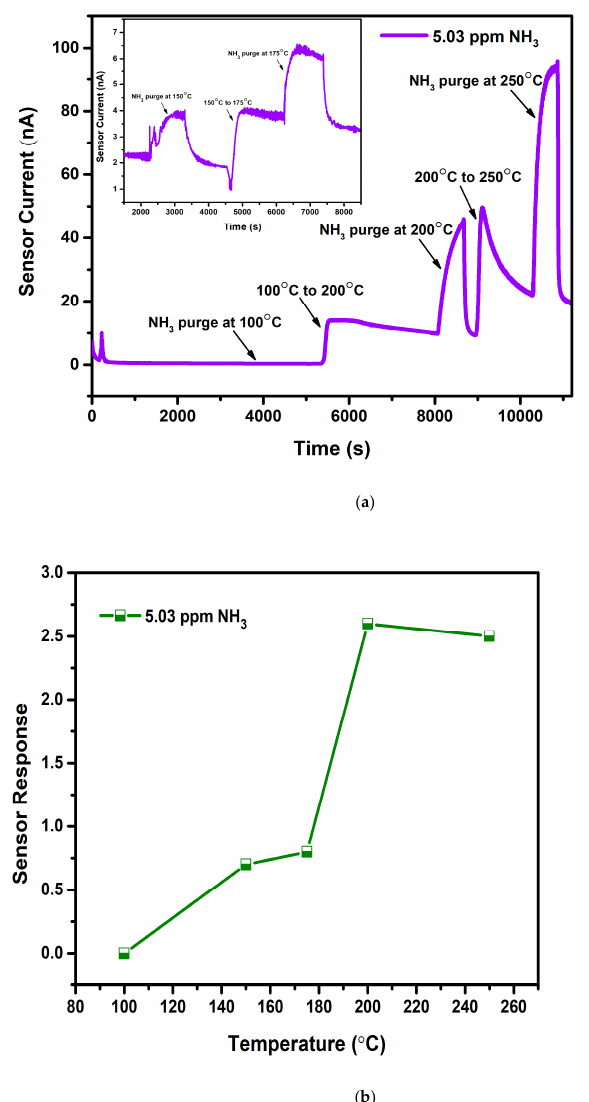
Figure 6. ( a ): Temperature optimization plot of WO 3 film at 100 ◦ C, 200 ◦ C, and 250 ◦ C (Inset: At 150 ◦ C and 175 ◦ C). ( b ): Sensor response vs. temperature plot for WO 3 film. Sensor response, rate of response, and recovery ( τ res and τ rec ) are the essential param- eters that determine the efficiency of any sensor. Figure 7a–d depicts the transient response curves of Ag–WO 3 films (0%, 1%, 3% and 5% Ag conc.) for different NH 3 concentrations. Figure 7e shows the variation of sensor response with the NH 3 concentration. The sensor response for 5 ppm NH 3 was found to be 1.06, 3.29, 0.34, and 0.62 with the standard